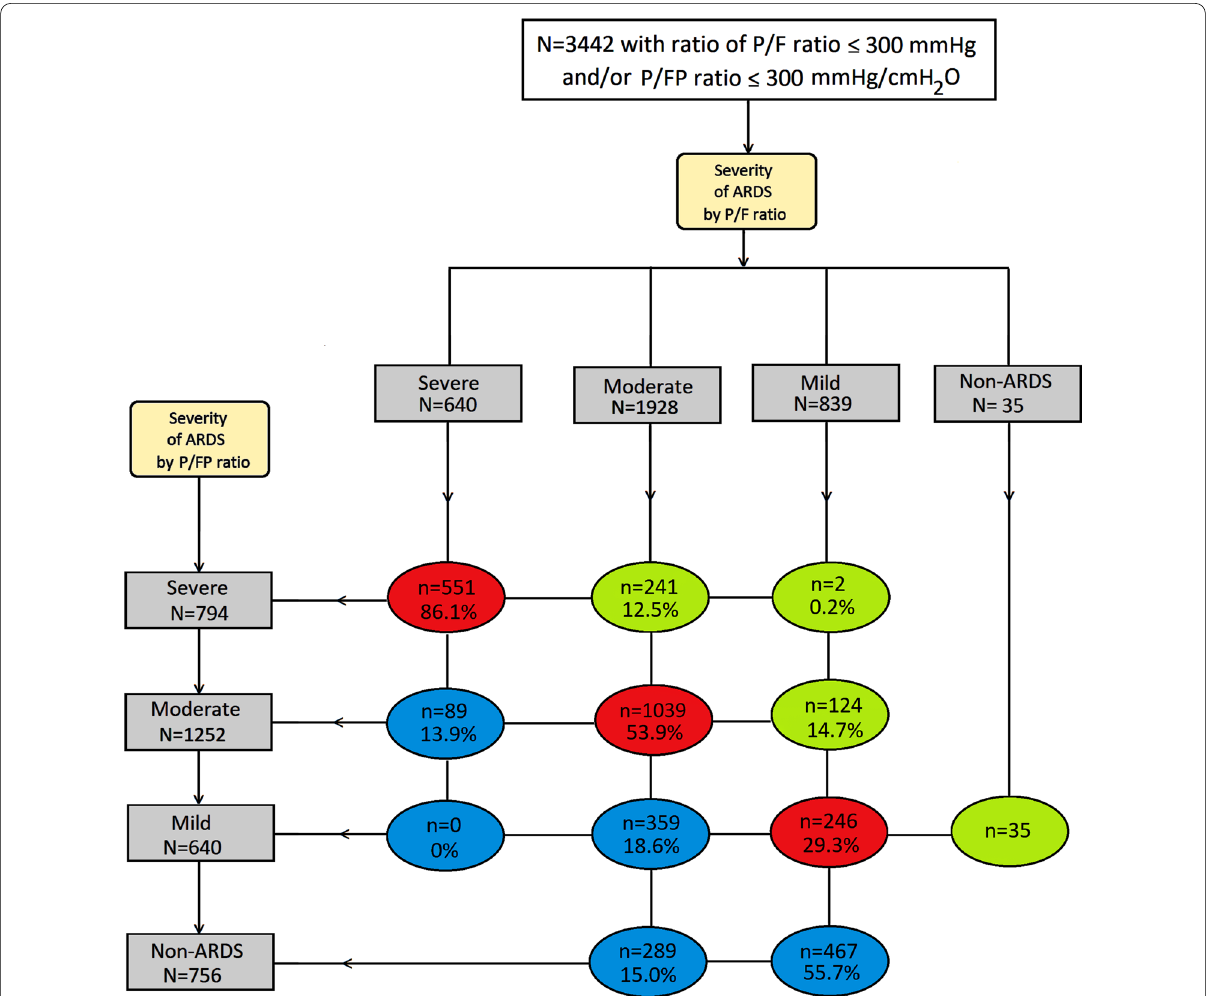
Fig. 1 Change of severity classifications when P/FP ratio is used instead of P/F ratio for severities. Severe refers to a ratio of to a ratio of 101–200, mild refers to a ratio of 201–300, non-ARDS refers to a ratio of > 300 mmHg or mmHg/cmH 2 O. Green ovals represent patients who were reclassified to a more severe category. Blue ovals represent patients who were reclassified to a milder category. Red ovals represent patients whose categories remained unchanged. Definition of abbreviations: ARDS acute respiratory distress syndrome; P/F ratio of the partial pressure of arterial oxygen (PaO 2 ) to the fraction of inspired oxygen (FiO 2 ); P/FP